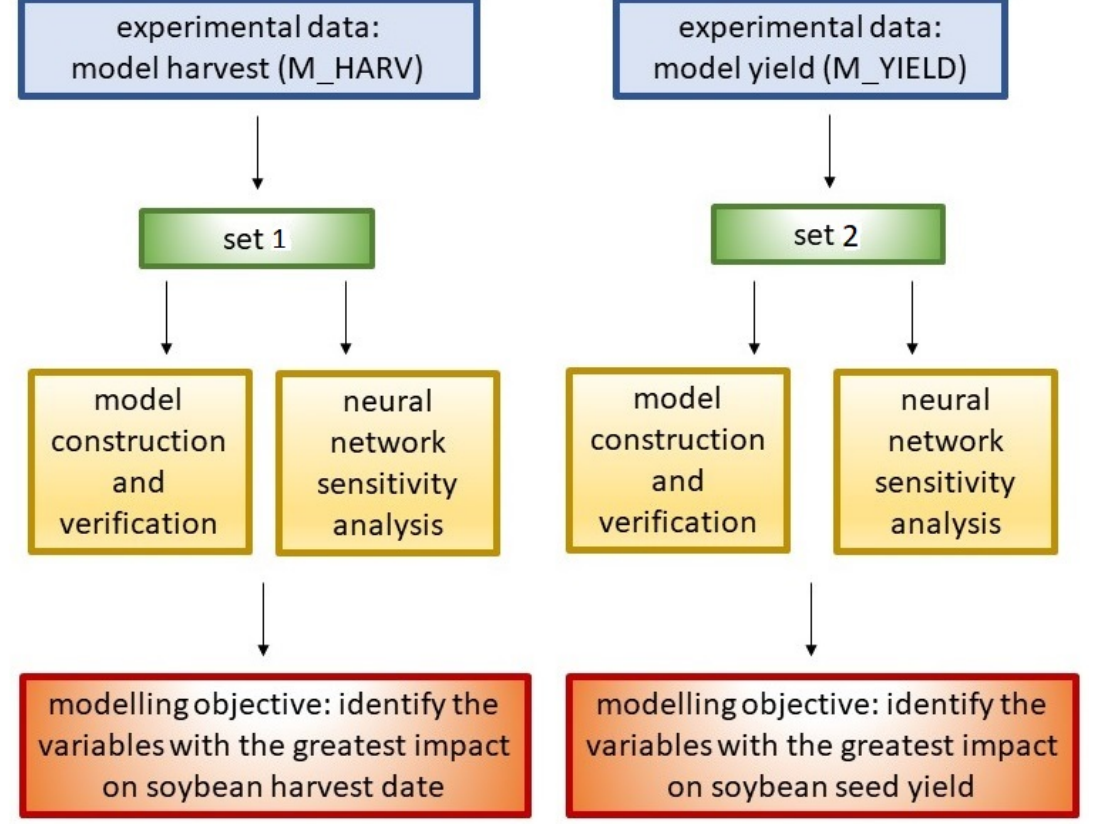
Figure 1. The division of experimental data into sets according to the assumptions made about the construction and application of deterministic models.